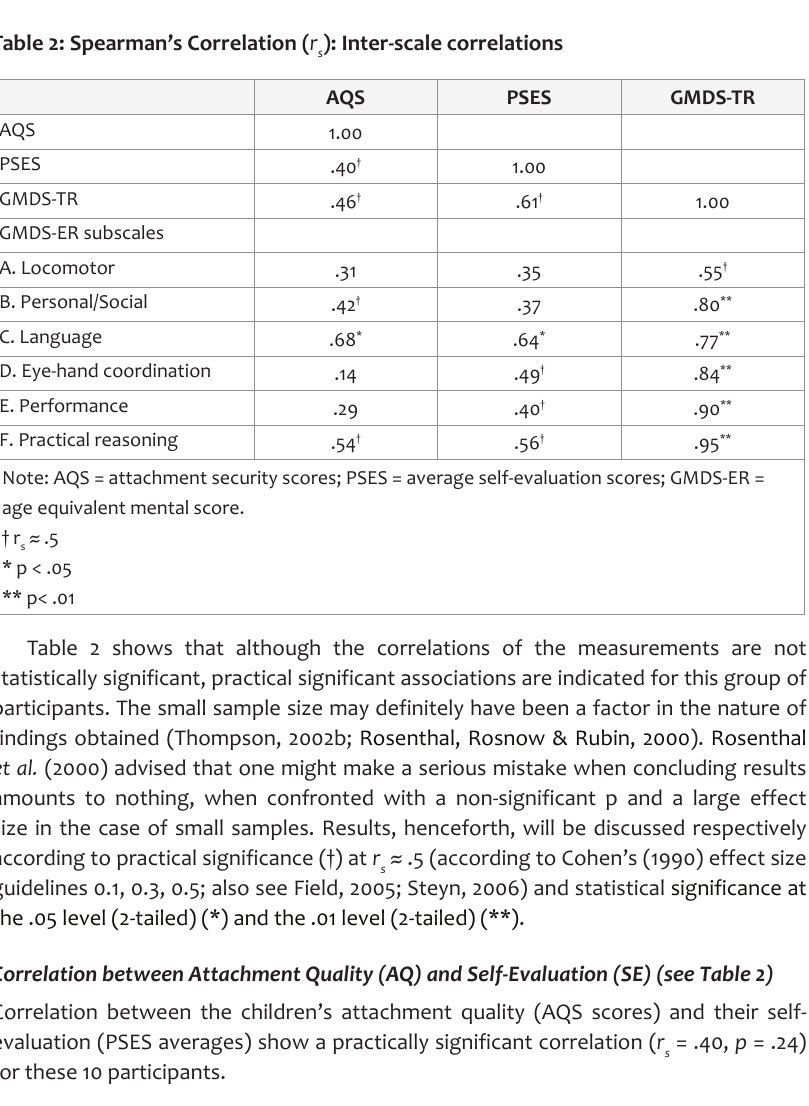
After computing Spearman’s rank-order coefficient on the security scores of the AQS and the Age equivalent scores of the GMDS-ER, for examination of the correlation between AQ and CD, results showed a practically significant ( r relationship between variables. Effect sizes reflect that the correlation is practically significant for the 10 dyad